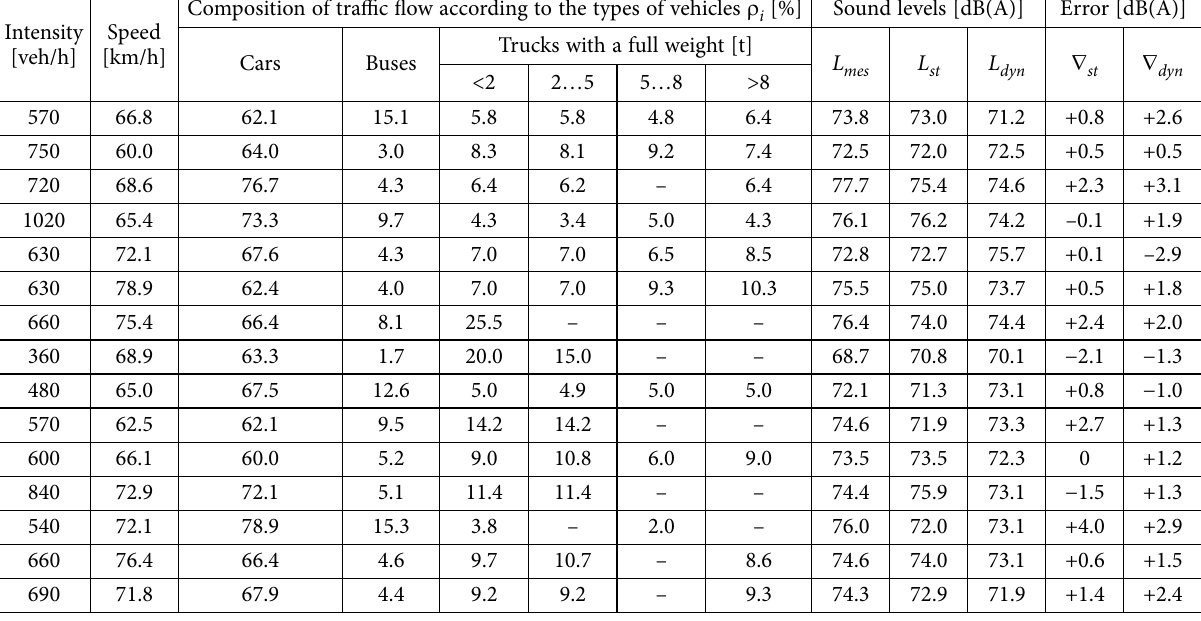
Table 3. Results of field measurements and analysis of calculation formulas Intensity Speed [veh/h] [km/h]